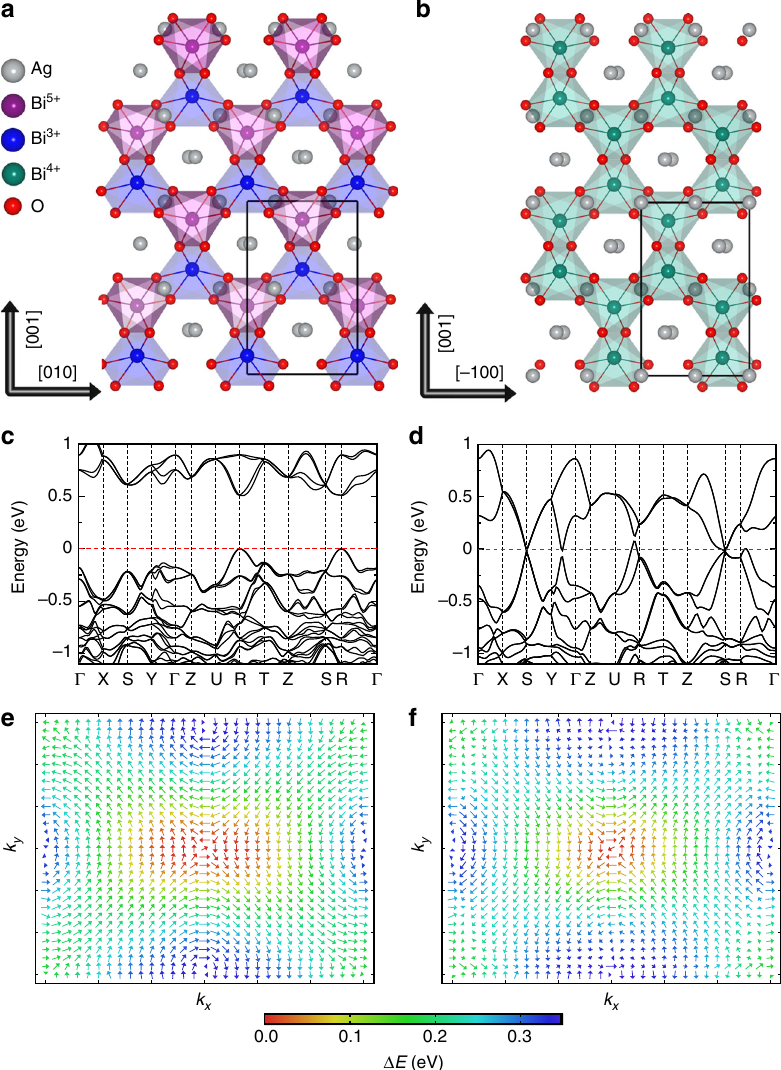
Fig. 1 Structural and electronic properties of Ag 2 BiO 3 . Crystal structure of a the ferroelectric Pnn 2 and b the hypothetical paraelectric Pnna phase. Red, gray, green, blue, and purple spheres are O 2 − , Ag + , Bi 4+ , Bi 3+ , and Bi 5+ ions, respectively. c and d are the band structures of the Pnn 2 and Pnna phases, respectively. The Fermi level is shifted to 0 eV. High symmetry points in the fi rst Brillouin zone are de fi ned in Supplementary Figure 1. e and f are the spin textures of the inner and outer branches of conduction bands at the R point in the polar Pnn 2 phase. The color code indicates the energy level with respect to the bottom of conduction